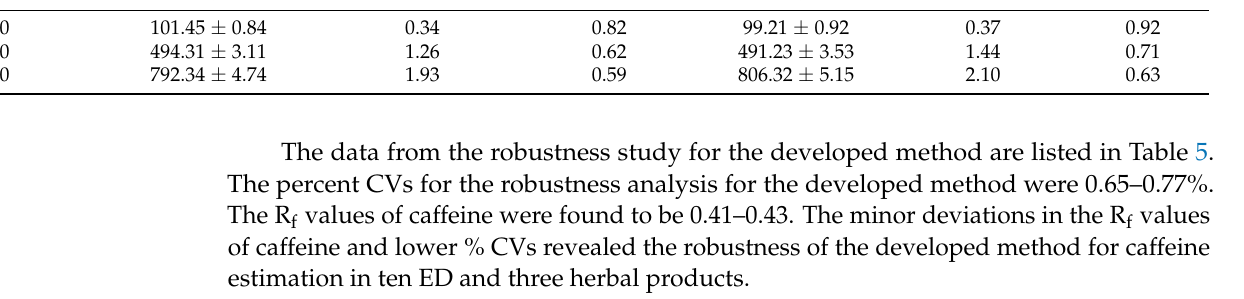
Table 5. Robustness assessment of findings of caffeine for the green HPTLC method (mean ± SD; n = 6).